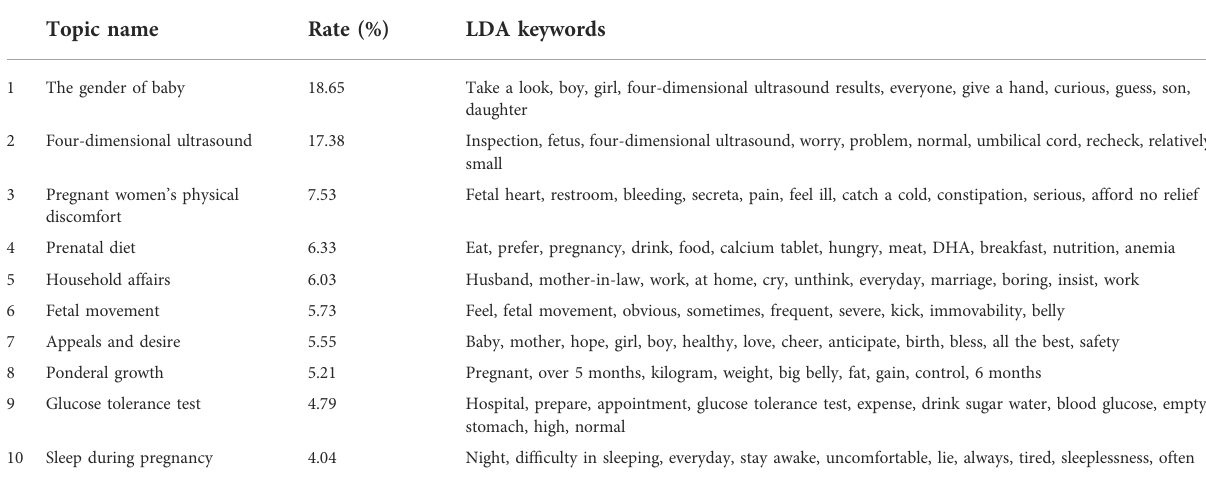
TABLE 9 Topics in the sixth month of